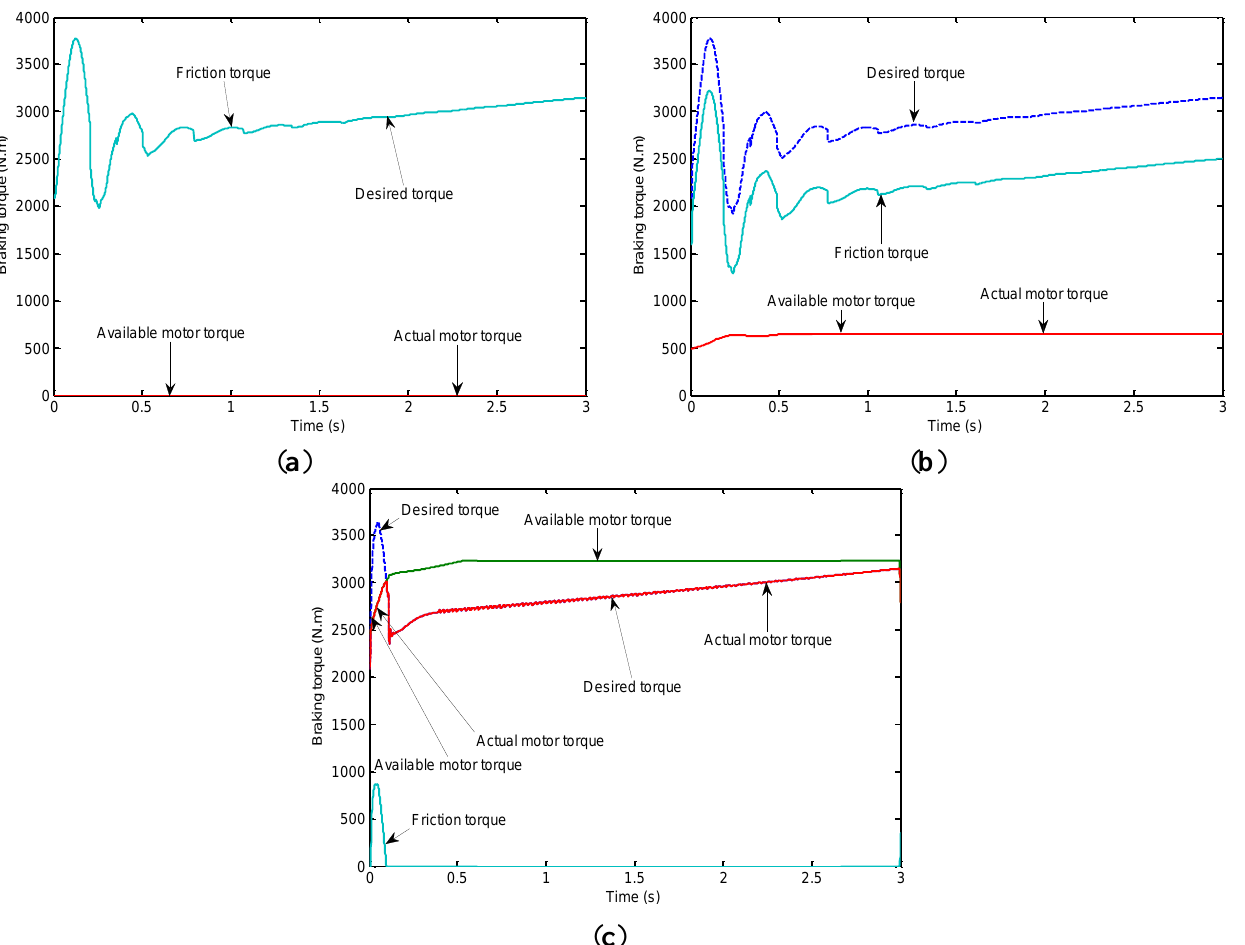
Figure 10. Distribution of braking force in cases: ( a ) H-ABS; ( b ) HM-ABS; and ( c )